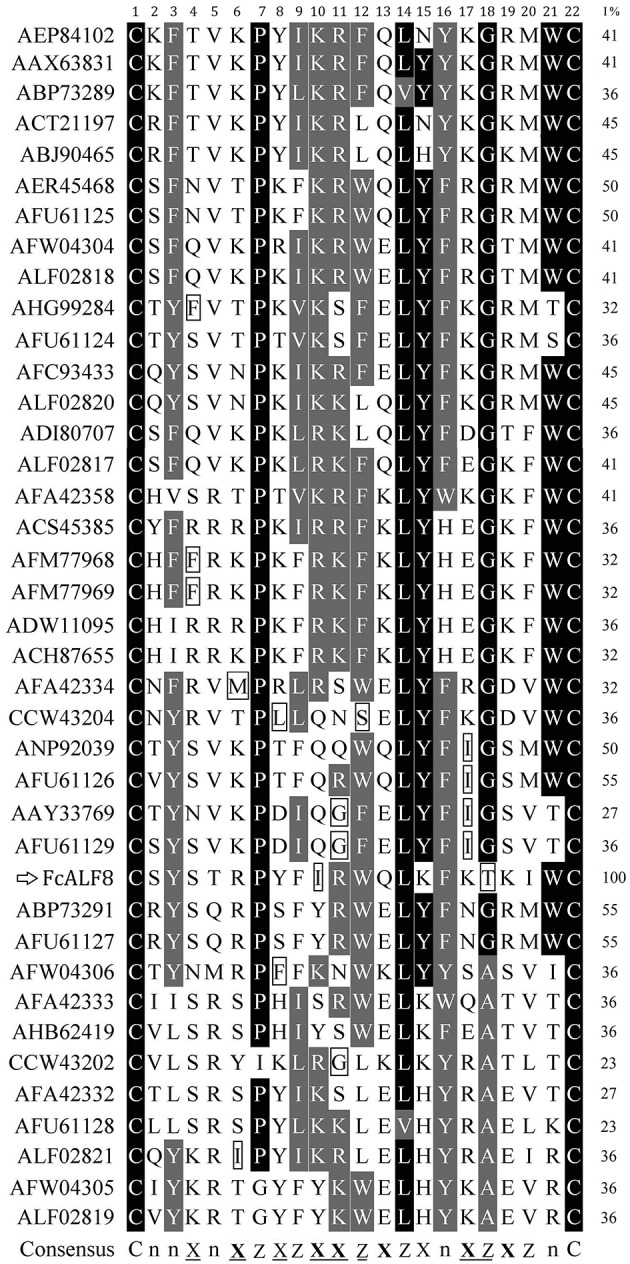
Sequence alignments of LBD peptides from different ALFs. The LBD peptides were showed with GenBank accession numbers of corresponding ALFs listed in Table 2. The amino acid residues in LBD sequences were numbered from 1 to 22. Identical and similar residues were shown in dark and gray, respectively. The % identities between LBD8 and other LBDs were listed in the right column (I%). The consensus sequence was generated by comparing the hydrophilic or hydrophobic properties of the amino acid residues in LBD peptides. In the consensus sequence, X showed hydrophilic residues, Z showed hydrophobic residues, and n showed variable residues. The underlined sites showed existence of <4 residues with distinct property. Six bolded X indicated the sites frequent existence of basic or acidic residues among these LBD sequences. Two conserved cysteine residues (C) were shown at two sides of the consensus sequence.